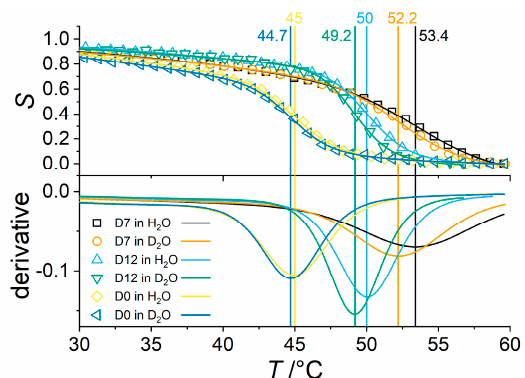
Figure 8. Influence of the solvent (H 2 O/D 2 O) on the VPTT of H-, D7-, and D12-pNIPMAM. ( Top ) Normalized hydrodynamic radius vs. the temperature with a fit describing the experimental data. ( Bottom ) Derivative of the fit in the upper part of the figure with vertical lines indicating the VPTTs.